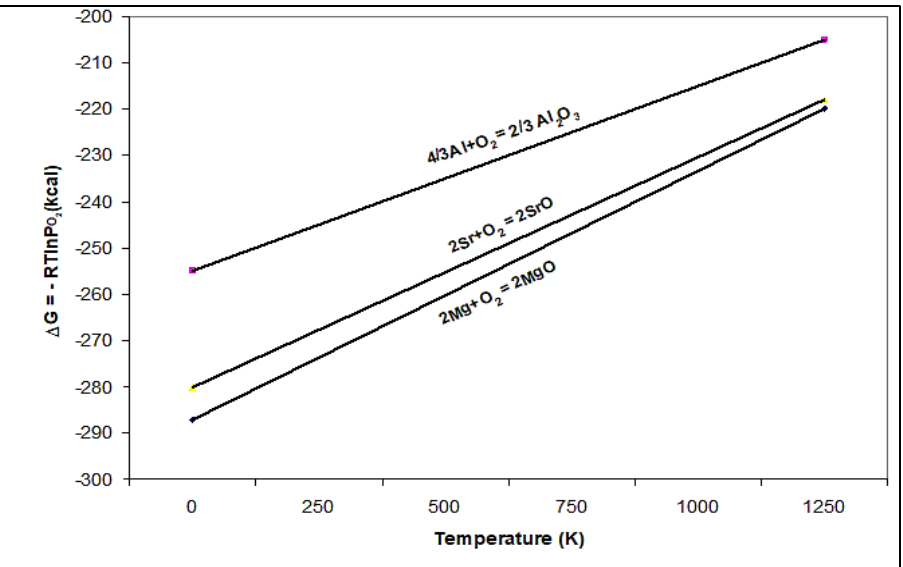
Figure 3. Calculated free energy for Sr oxidation.